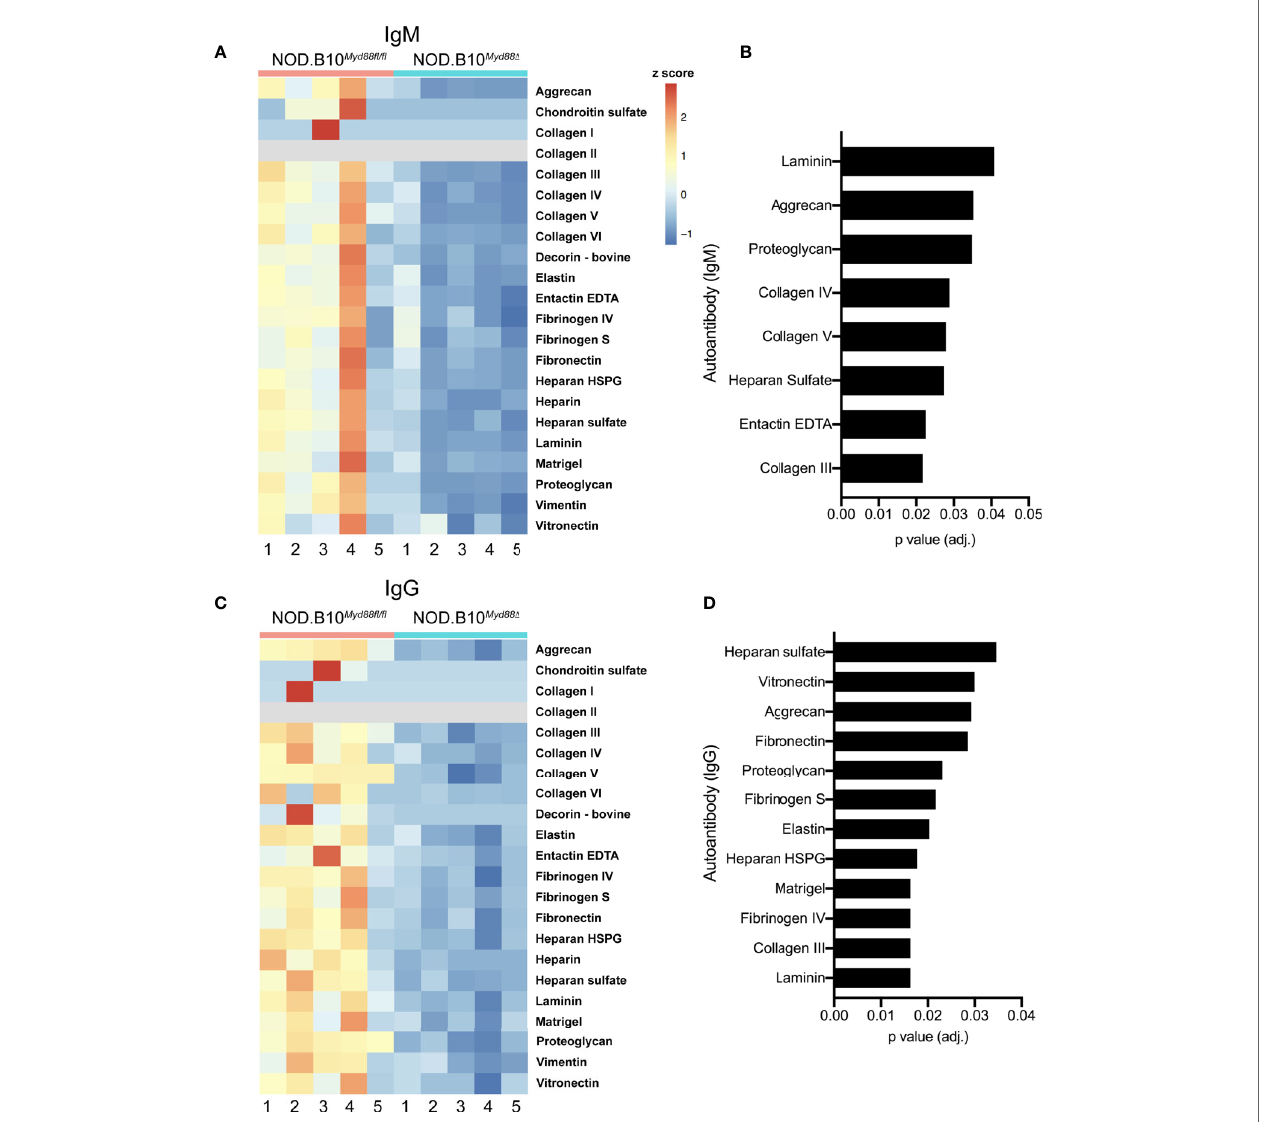
FIGURE 6 | Anti-ECM antibodies are diminished in pSS animals that lack Myd88 in hematopoietic tissue. Sera were harvested from NOD.B10 Myd88 fl / fl and NOD.B10 Myd88 D mice (n = 5 each). (A, C) IgM and IgG autoantibodies were assayed by autoantigen array and heatmaps are provided to summarize the data. Analysis of autoantigen array data reveals signi fi cant differences in ECM-speci fi c (B) IgM and (D)